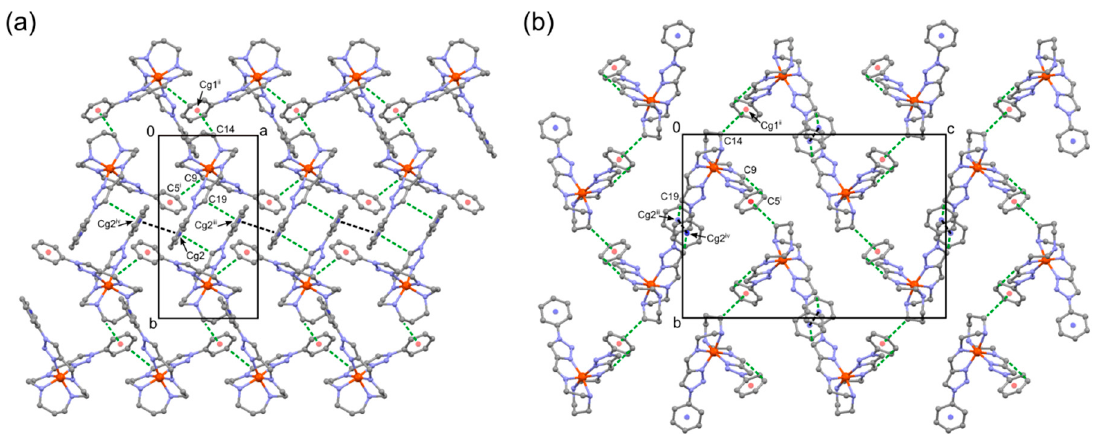
Figure 6. Molecular arrangement of 1 at 296 K, projected on the ( a ) ab -plane and ( b ) bc -plane. Adjacent complex cations [Fe(L 2-3-2Ph )] 2+ are connected by intermolecular CH · · · π (green dotted line) and π – π (black dotted line) interactions, forming the 3D network. Cg1 = centroid of the C1–C6 ring (transparent red) and Cg2 = centroid of the C20–C25 ring (transparent blue). Symmetry operations: (i) − x, y, 3/2 − z, (ii) x, − 1 + y, z, (iii) − x, − 1 + y, 3/2 − z, (iv), − x, 1 − y, − z. H atoms and AsF 6 − ions have been omitted for clarity.